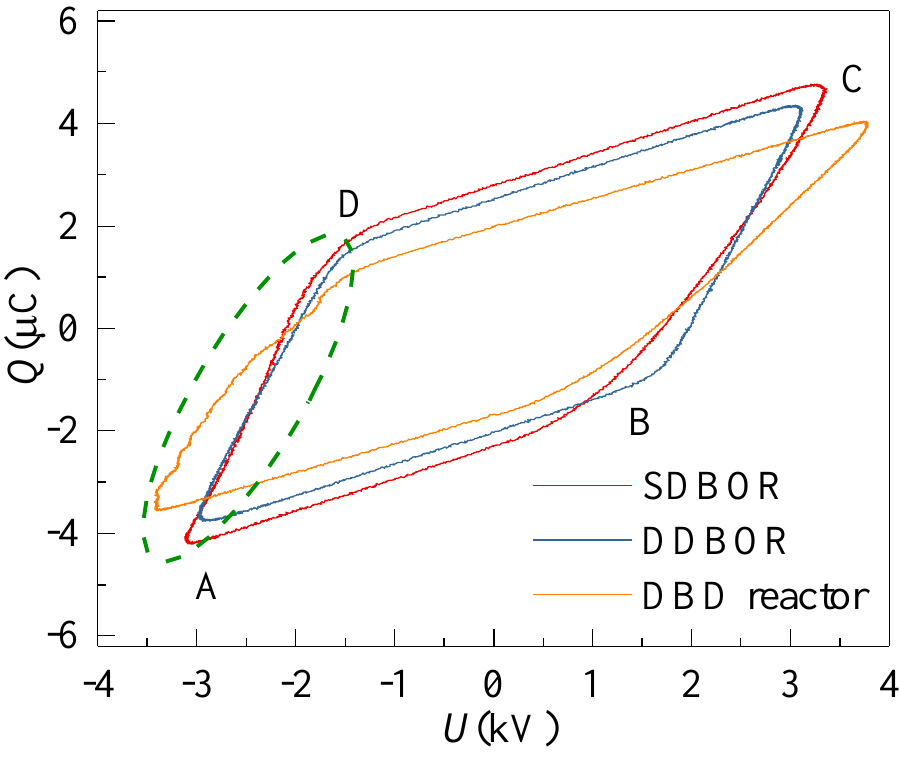
Figure 6. Lissajous Figure of SL-DBD (SDBOR, DDBOR) and DBD reactor without silver layer (applied voltage = 2.8 kV, discharge gap = 0.5 mm).